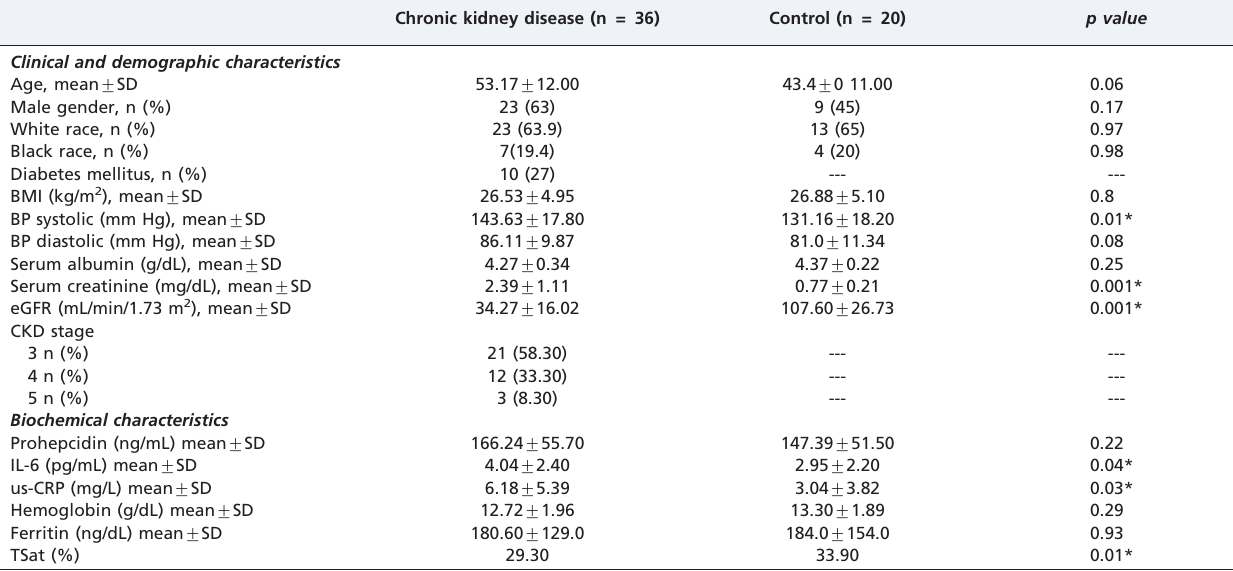
Chronic kidney disease (n = 36)